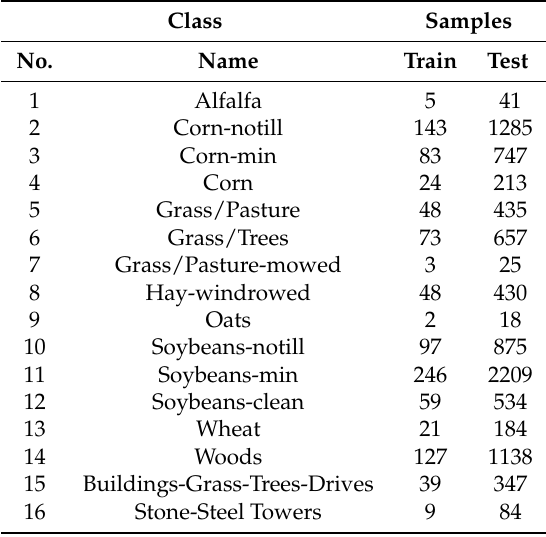
Table 2. Nine classes in the University of Pavia and the training and test sets for each class.